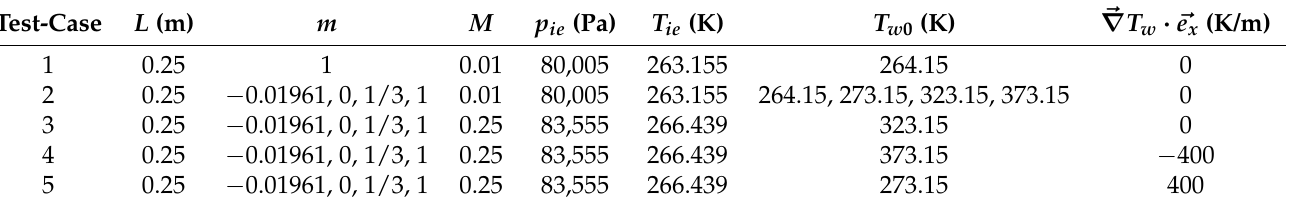
Table 1. Physical parameters for the test cases. M is the Mach number at the end of the plate ( x = L ), T w 0 is the wall temperature at x = 0, p ie and T ie are the total pressure and total temperature of the edge flow,